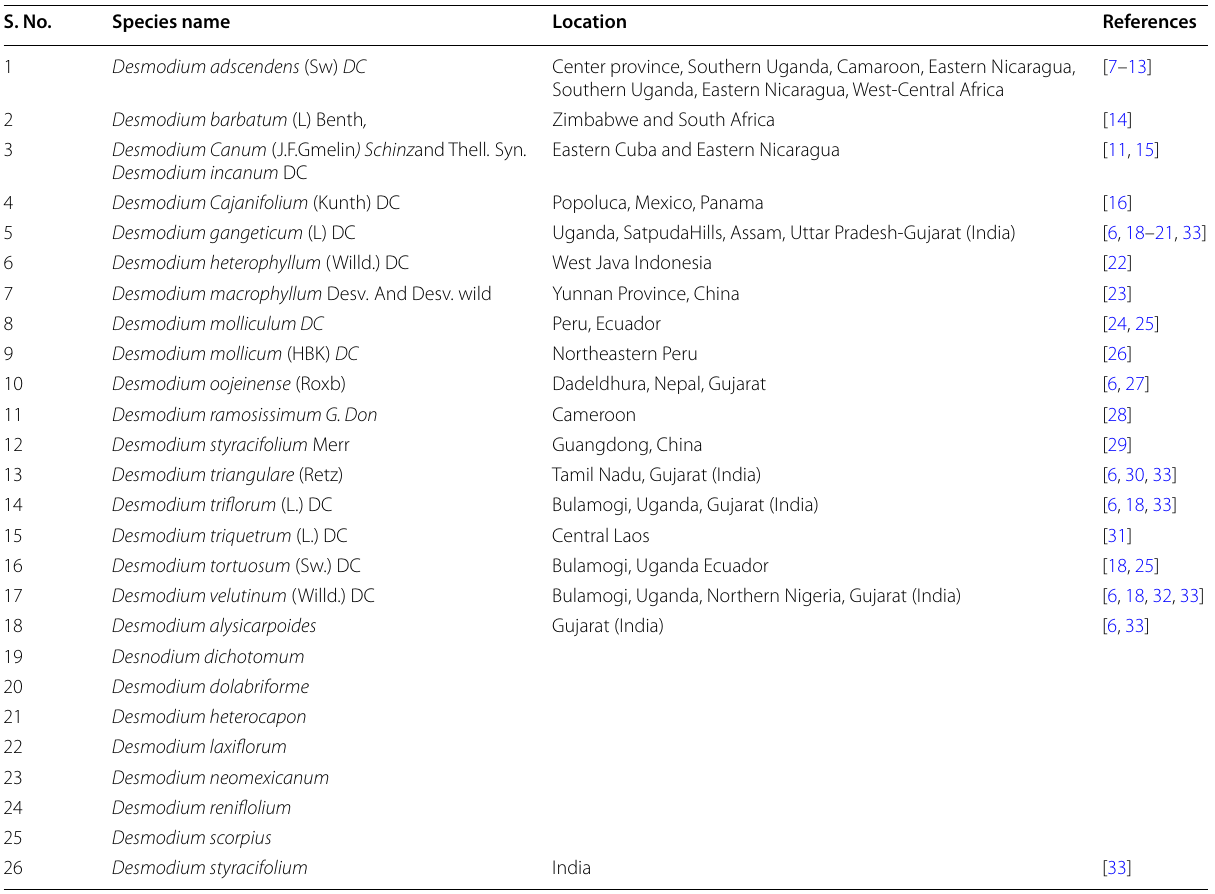
Table 1 Distribution of various Desmodium species in the world and Gujarat (India) S.